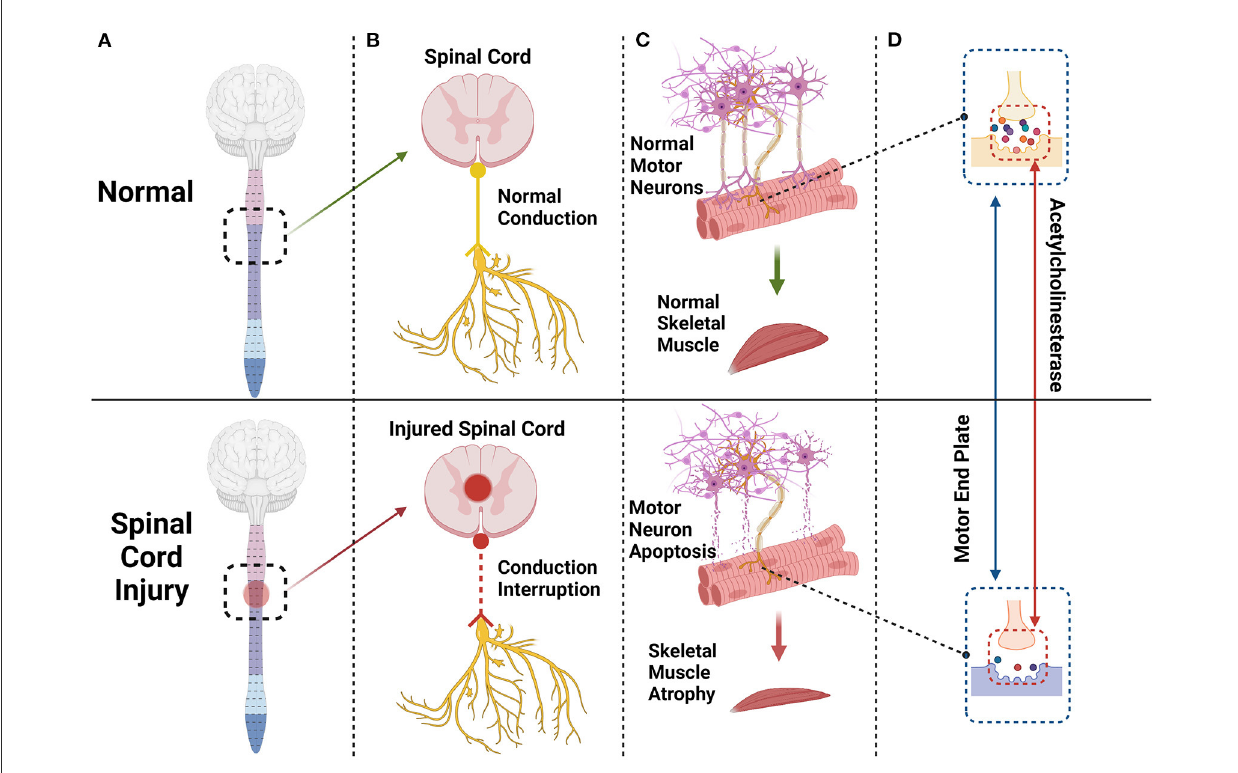
FIGURE1 The spinal cord and brain constitute the central nervous system. After a spinal cord injury (A) the conduction of peripheral nerves innervating skeletal muscle will be interrupted or blocked (B) and some motor neurons innervating skeletal muscle will undergo apoptosis (C) Endplates degenerate, and acetylcholinesterase content of synapses will decrease significantly (D) eventually leading to skeletal muscle atrophy (C) .